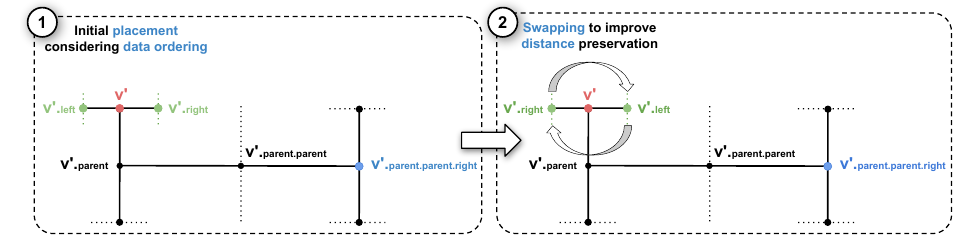
Figure 2. H-tree with swaps. The children v (cid:48) . left or v (cid:48) . right of a node v (cid:48) in the left sub-tree can be swapped to put closer to the sibling of its parent vertex v (cid:48) . parent . parent . right the most similar child to it. This operation potentially result in a layout with better local distance preservation (the right sub-tree) without changing the tree topology. Algorithm 2 Swapping H-tree